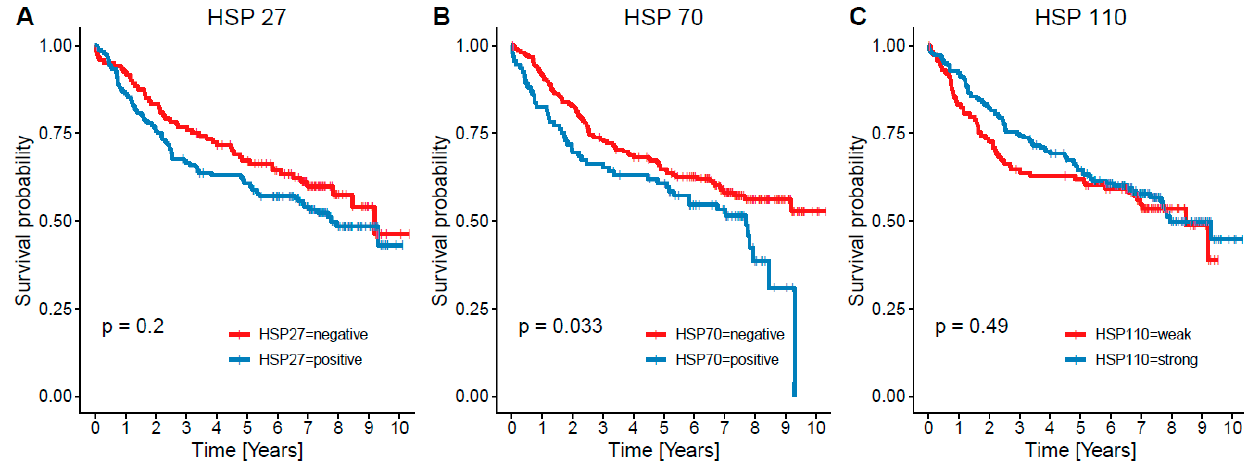
Cancers 2021 , 13 , 4407 Figure 2. Kaplan–Meier curve documenting overall survival (OS) in relation to heat shock protein (HSP) status whereas only HSP27 shows a significant negative impact on survival. In HSP27, there was a visible trend, although insignificant.